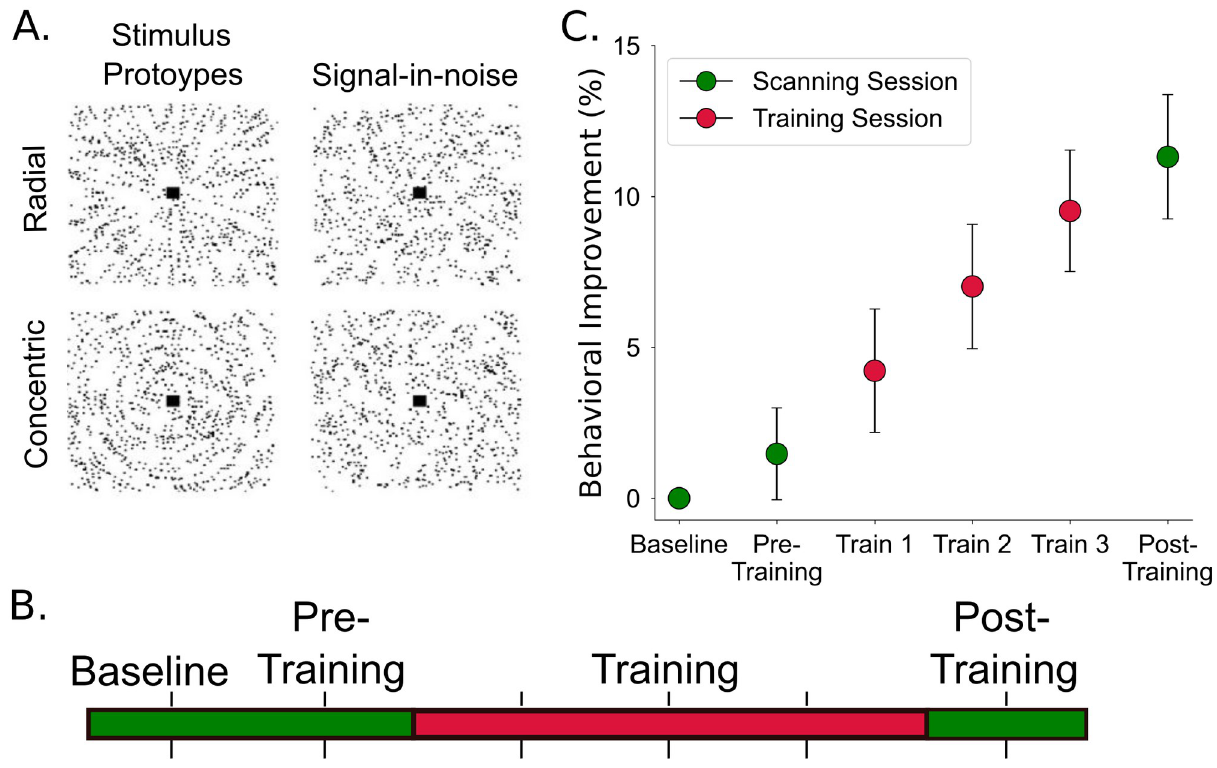
Fig 1. Experimental design and stimuli. (A ) Radial and concentric Glass patterns are shown with inverted contrast for illustration purposes. Left: Prototype stimuli: 100% signal, spiral angle 0˚ for radial and 90˚ for concentric. Right: Stimuli used in the study: 25% signal, spiral angle 0˚ for radial and 90˚ for concentric. ( B ) Participants were trained on a signal-in-noise detection task with feedback for 3 consecutive training sessions (one per day). Participants completed the task without feedback in MRI test sessions before (baseline, pre-training) and after (post-training) training. ( C ) Percent behavioral improvement (mean performance per-session minus performance at baseline, divided by performance at baseline) across participants for test (green, in MRI scanner) and training (red, in laboratory) sessions ( n = 20). Error bars indicate SEM across participants. Source data are provided